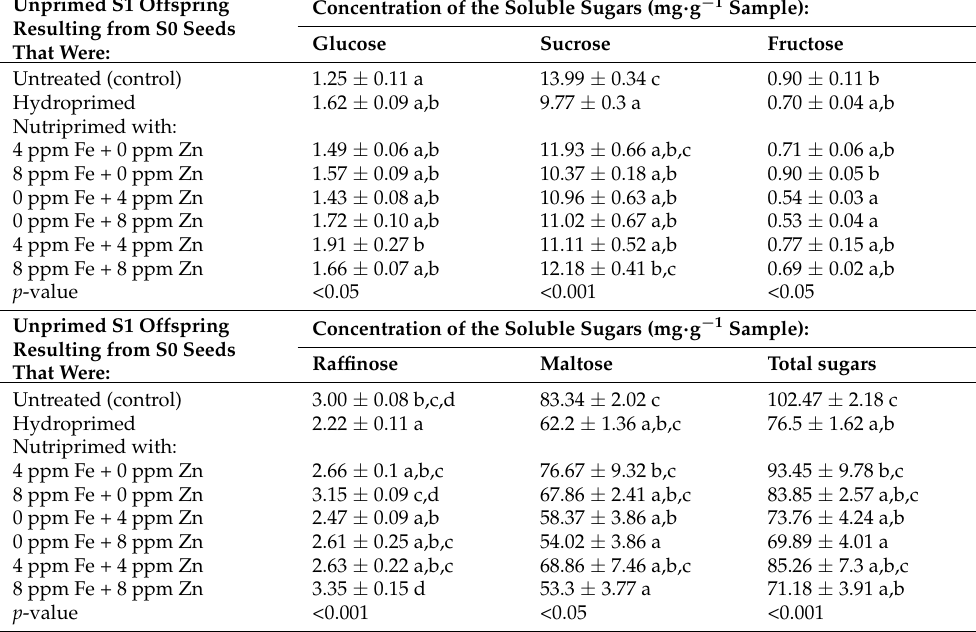
Table 2. Mean ( ± S.E.) concentration of soluble sugars (mg · g − 1 sample) determined per unprimed S1 offspring resulting from S0 seeds that were untreated (control), hydroprimed, or nutriprimed with Fe and/or Zn. The mean values resulted from nine replicates. Values followed by different lowercase letters represent statistically significant differences ( p < 0.05) among S1